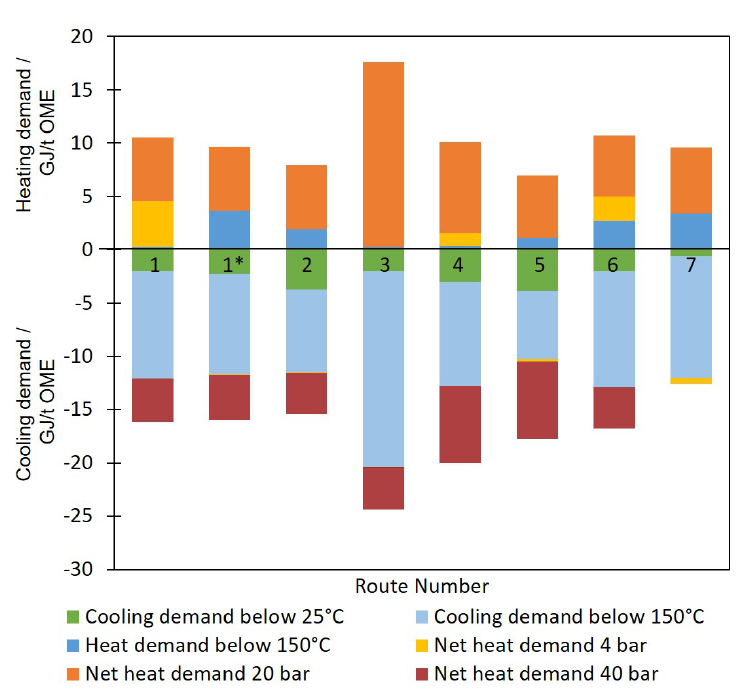
Figure 2. Net heat demand per t OME at every steam level (40, 20, 4 bar) for all routes. Excess heat is negative, heat demand